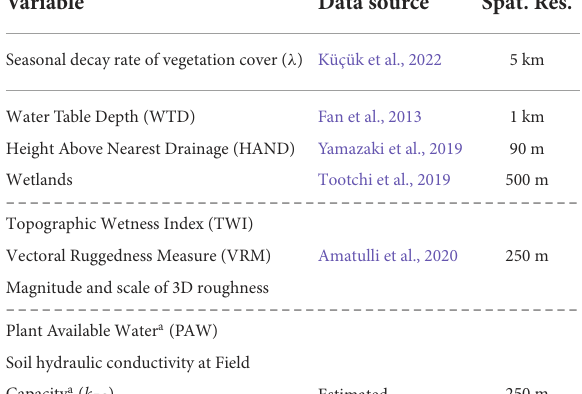
TABLE 1 Summary of the datasets used in the study. Variable Data source Spat.